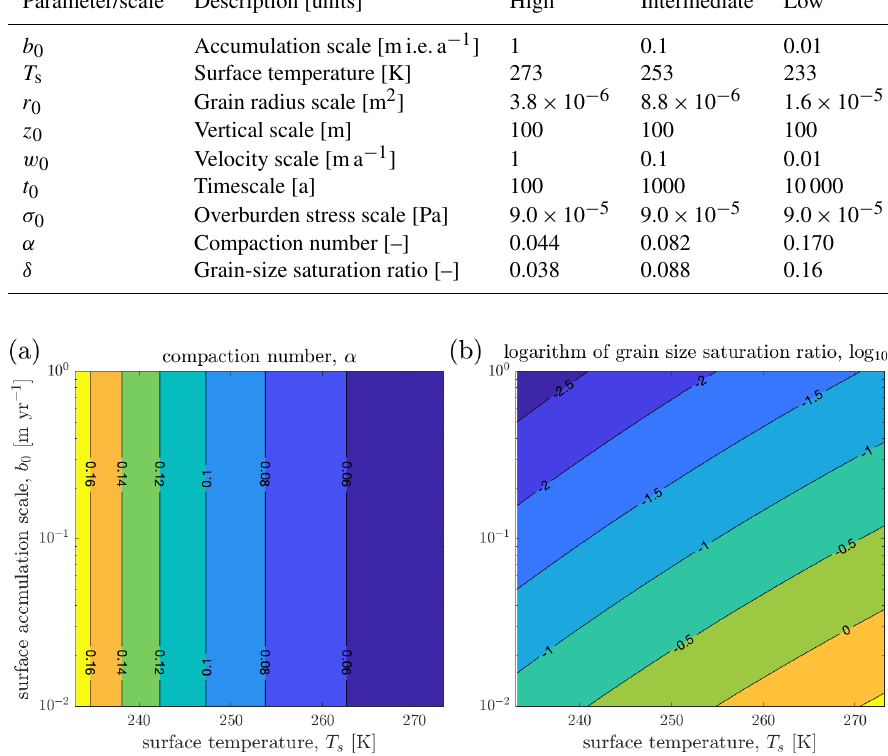
Figure 1. Two model parameters, (a) the compaction number α and (b) the base-10 logarithm of the grain-size saturation ratio δ , evaluated for a range of accumulation scales b 0 and surface temperatures T s